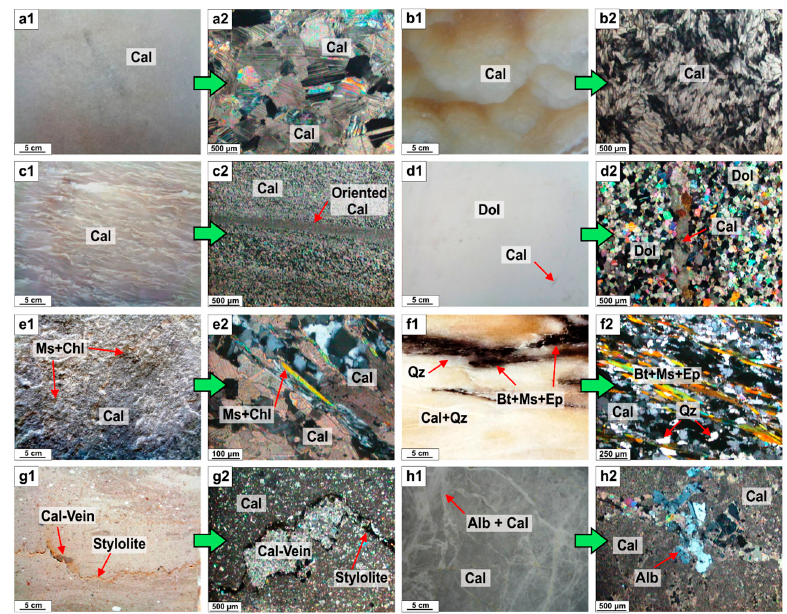
Figure 2. Macroscopic images and crossed polars photomicrographs (1 and 2 respectively) ( a ) Calcitic marble sample KM_1 composed of hypidiomorphic calcite (Cal) crystals. ( b ) The “crinkled” structure of alabaster calcitic marble STE_12 composed of elongated anisotropic calcite (Cal) crystals gathering in groups with different orientation. ( c ) Calcitic marble sample TH-3 composed of oriented calcite (Cal) crystals of different grain size. ( d ) Dolomitic marble sample AM_19 in which calcite (Cal) occurs in veins within a dolomite (Dol) rich groundmass. ( e ) Cipollino marble sample TH-6 including calcite (Cal) crystals along with muscovite (Ms), chlorite (Chl) and quartz (Qtz) ( f ) Calcitic marble sample TH-2 including calcite (Cal) crystals along with muscovite (Ms). ( g ) Limestone sample H_7 including secondary calcite veins (Cal) and stylolites. ( h ) Dolomite sample STE_1 consisting of dolomitic (Dol) groundmass and veins of secondary material filled with calcite (Cal) and albite (Alb).